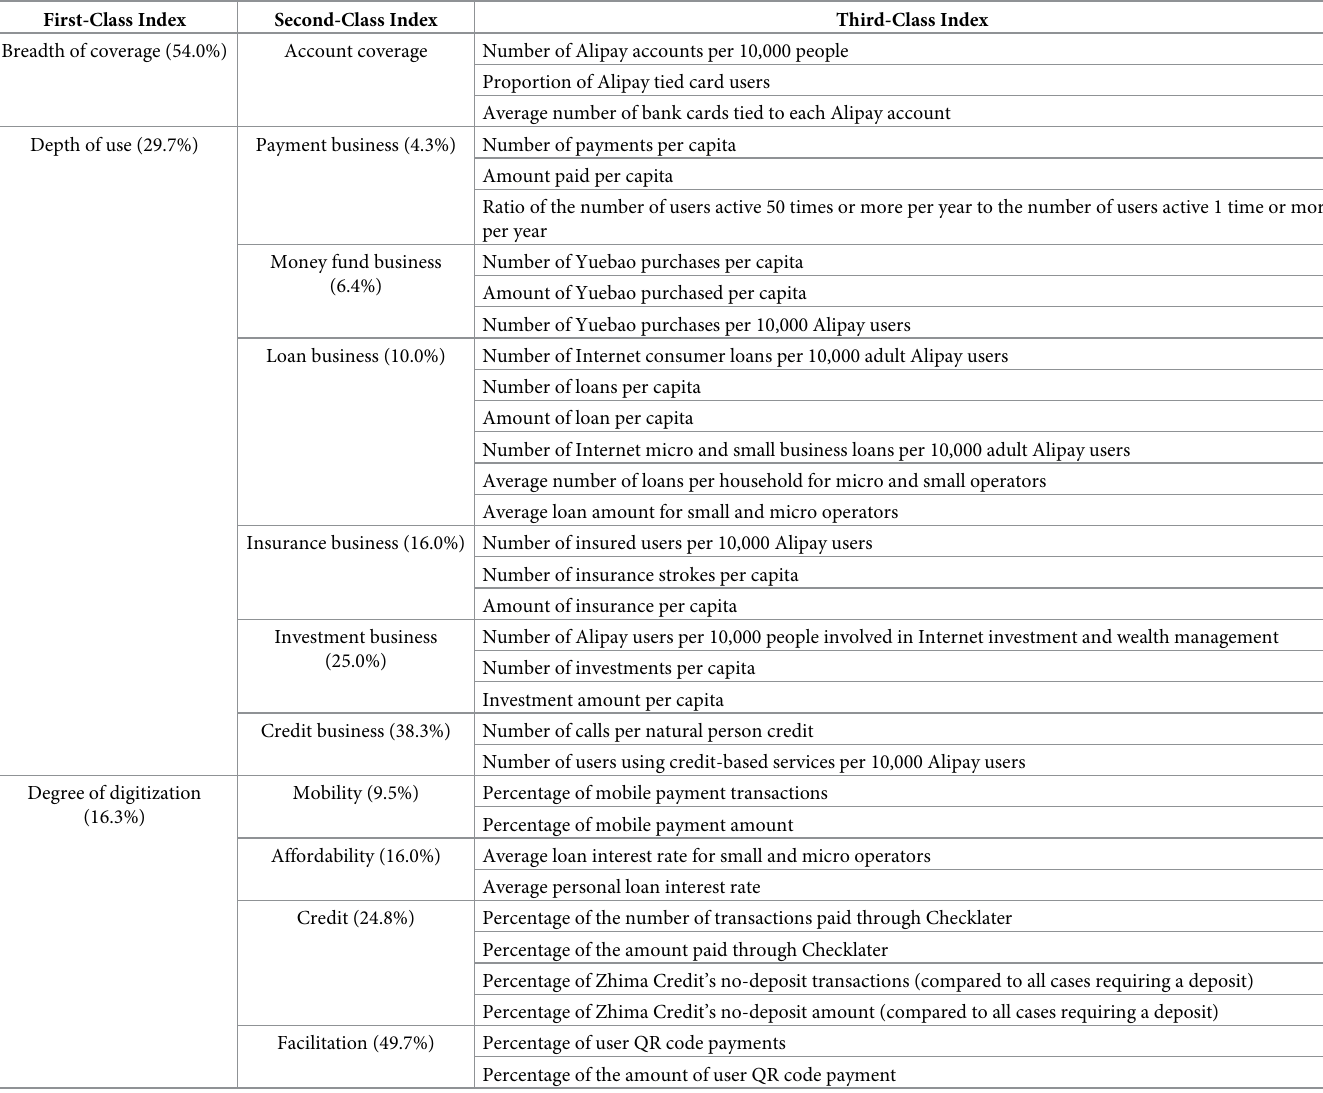
Table 2. Index system of digital finance